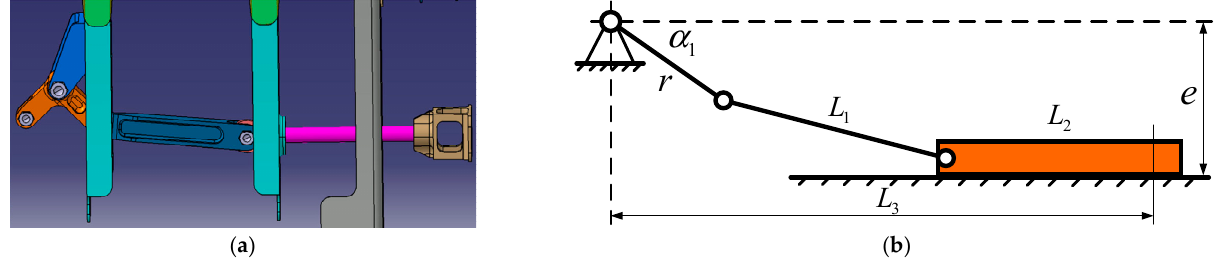
Figure 2. The latch lock mechanism of hatch. ( a ) The simulation model; ( b ) The visualized model.